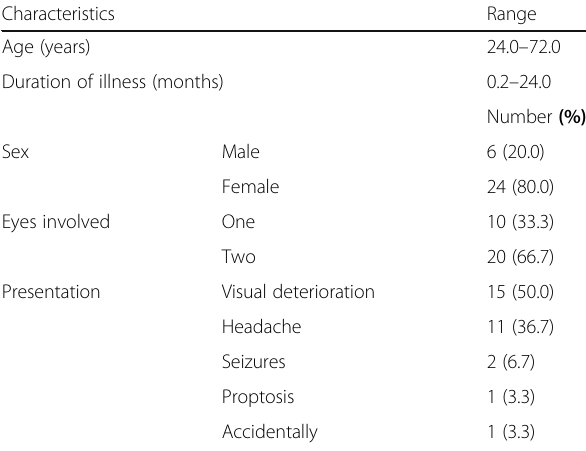
Table 1 Patients ’ basic clinical characteristics